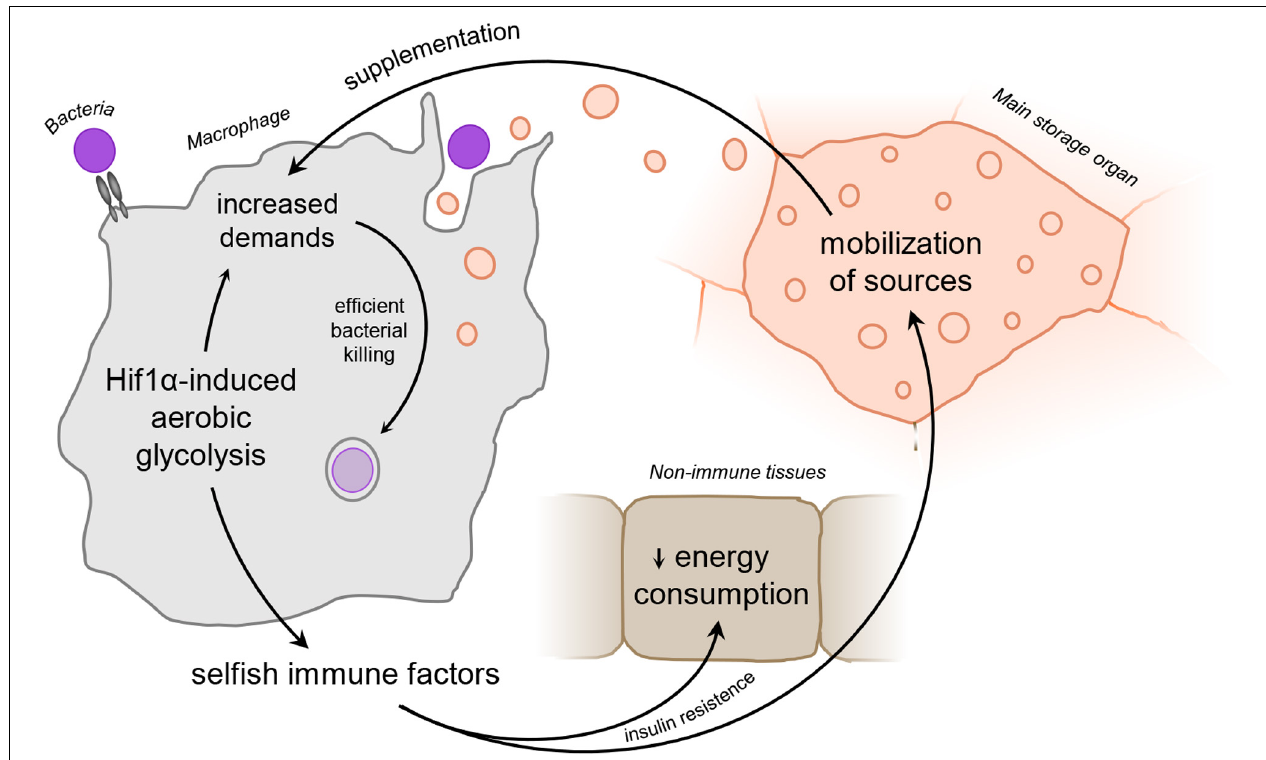
FIGURE 1 | Schematic representation of the “selfish immune system theory.” Infection-activated macrophages adopt Hif1 α -induced aerobic glycolysis and subsequently release signaling factors to ensure sufficient amount of nutrients to supplement the immune function. Hif1 α , hypoxia-inducible factor 1 α